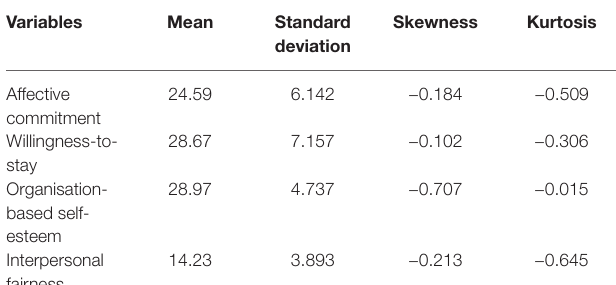
TABLE 1 | Descriptive statistics and